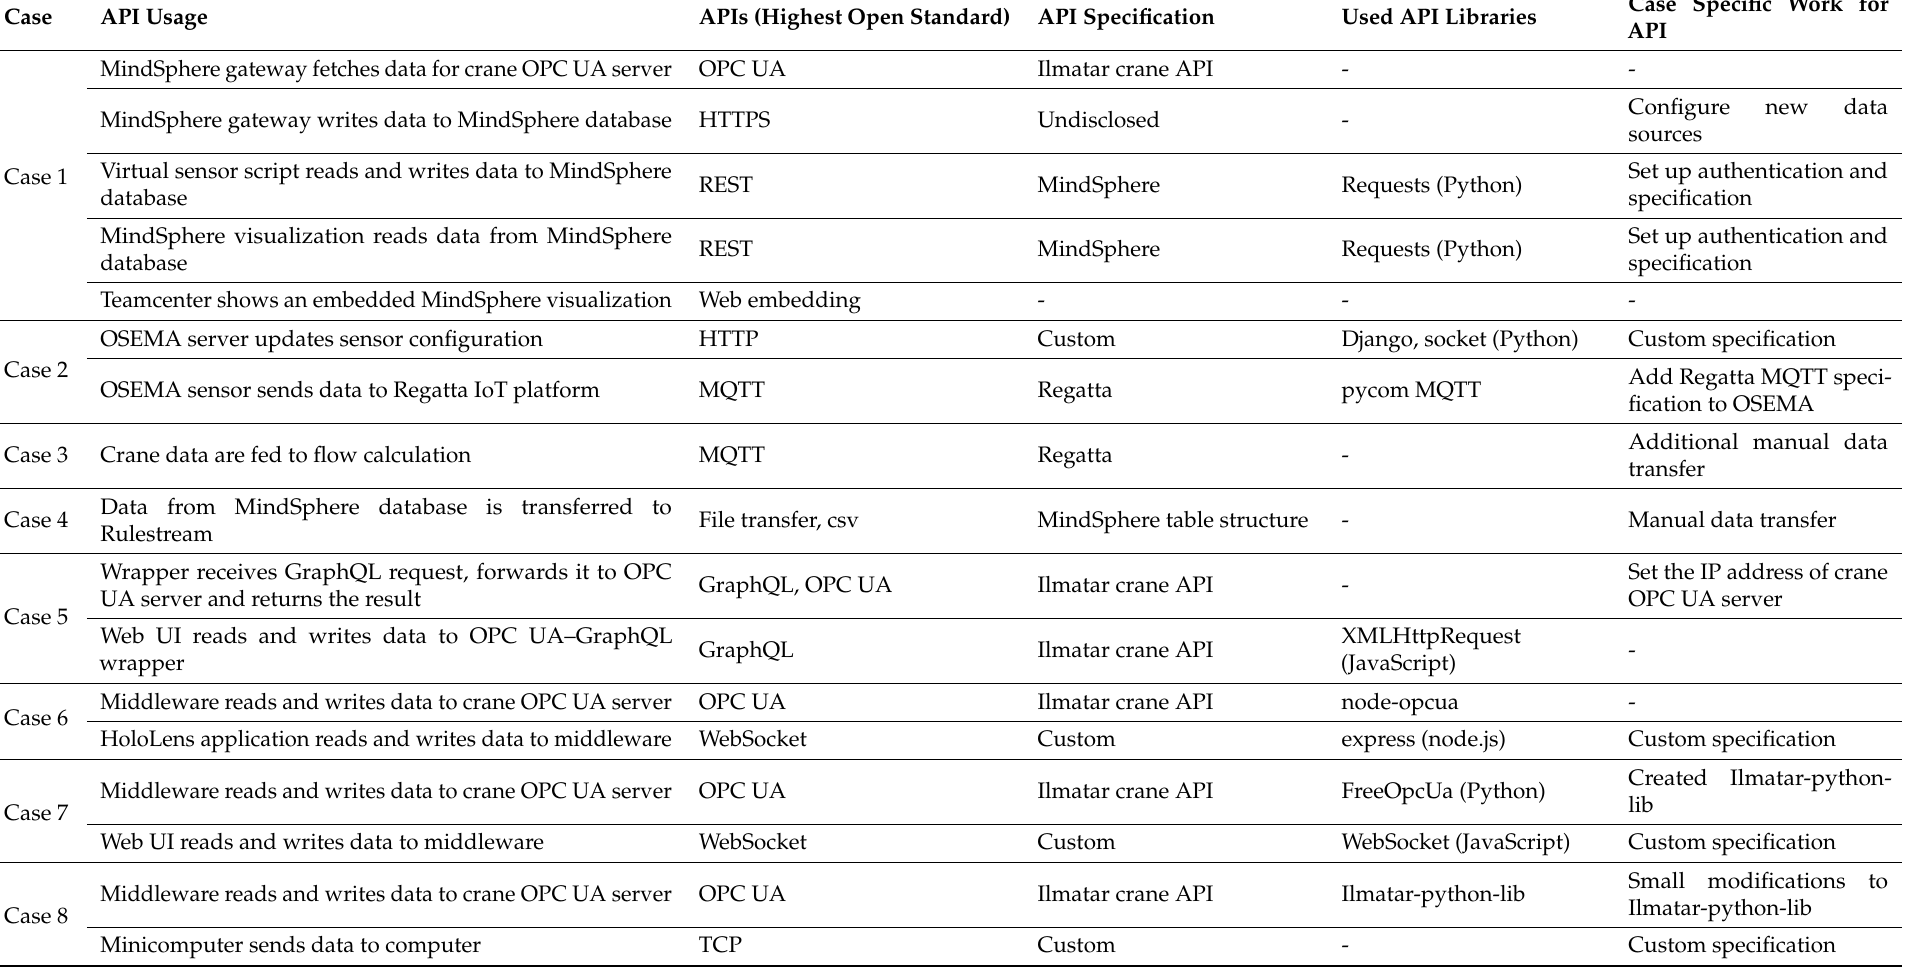
Table 1. Usage of APIs during the development of Ilmatar digital